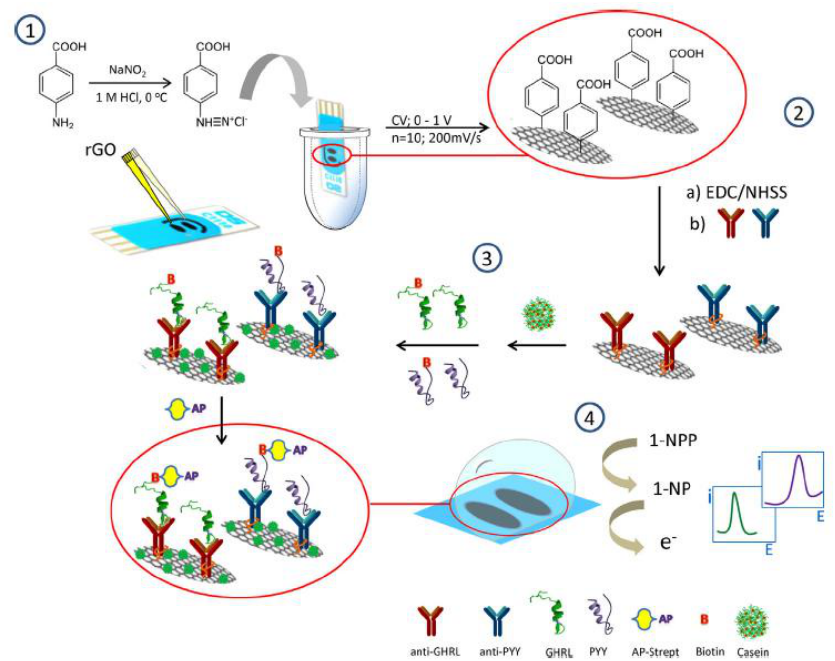
Figure 5. Schematic illustration of the different steps and protocols involved in the preparation and functioning of the dual GHRL and PYY immunosensor. Reprinted from [63] with permission.